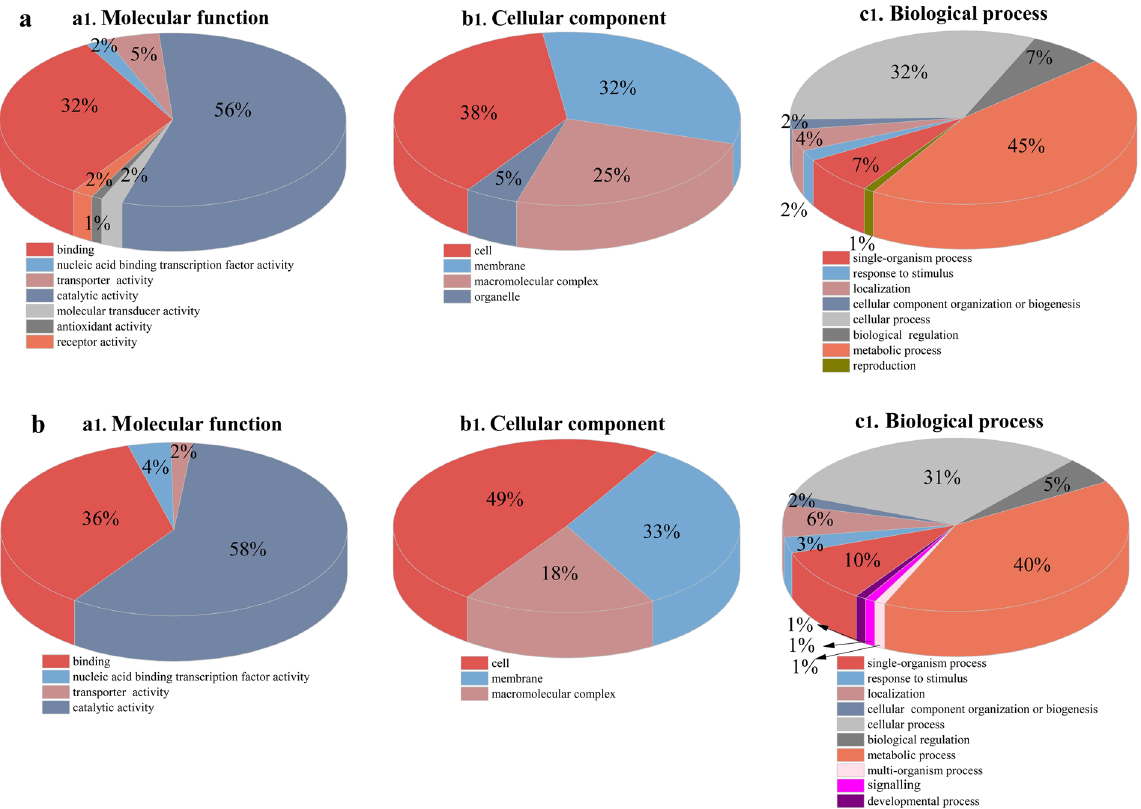
Figure 2. Map of gene ontology (GO) annotation. Classifications of all altered proteins in mono-cultivation ( a ) and co-cultivation ( b ), based on molecular function ( a1 ), subcellular localization ( b1 ), and biological process ( c1